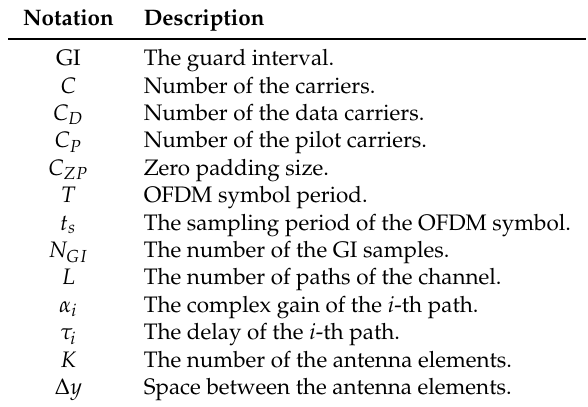
Figure 1. Discrete baseband OFDM system with antenna array. Table 1. Major notations used in this